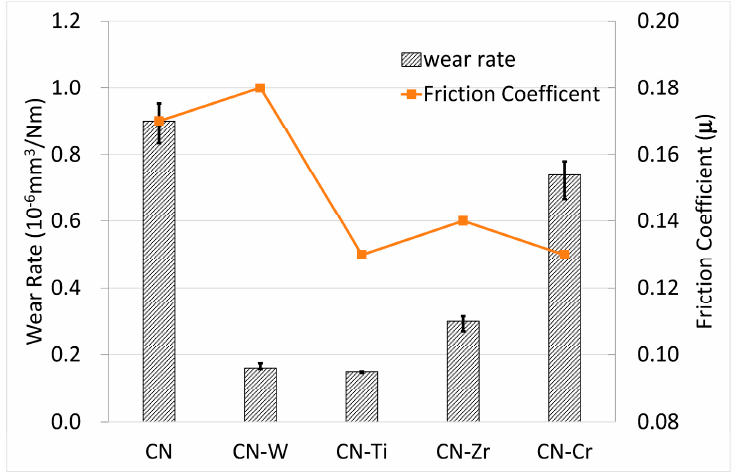
Figure 10. Comparison of wear test results of CNx and 6 at. % metal-doped CNx coated samples